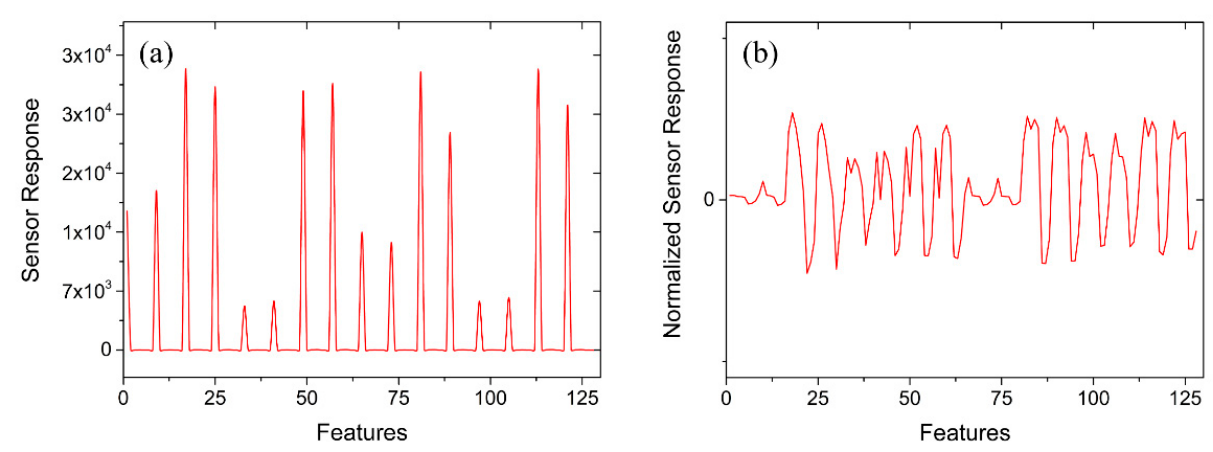
Figure 4. Original sensor array response and normalized sensor array response. ( a ) Original sensor array output response. ( b ) Normalized sensor array output response.